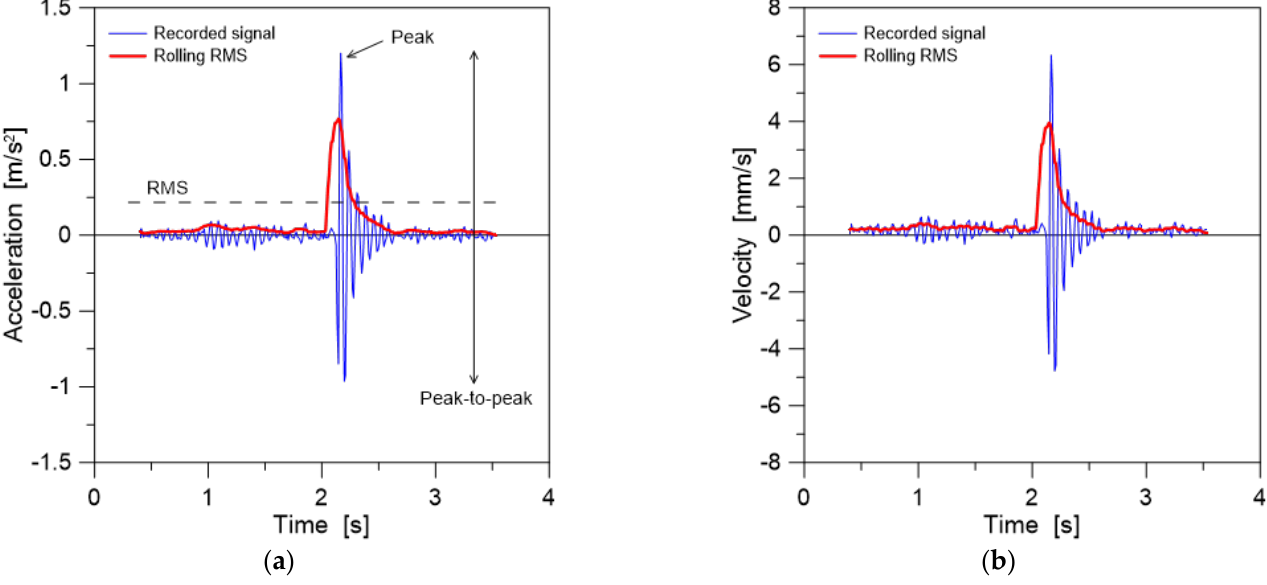
Figure 11. Qualitative example of typical ( a ) acceleration and ( b ) velocity experimental signal due to a single footfall of the involved